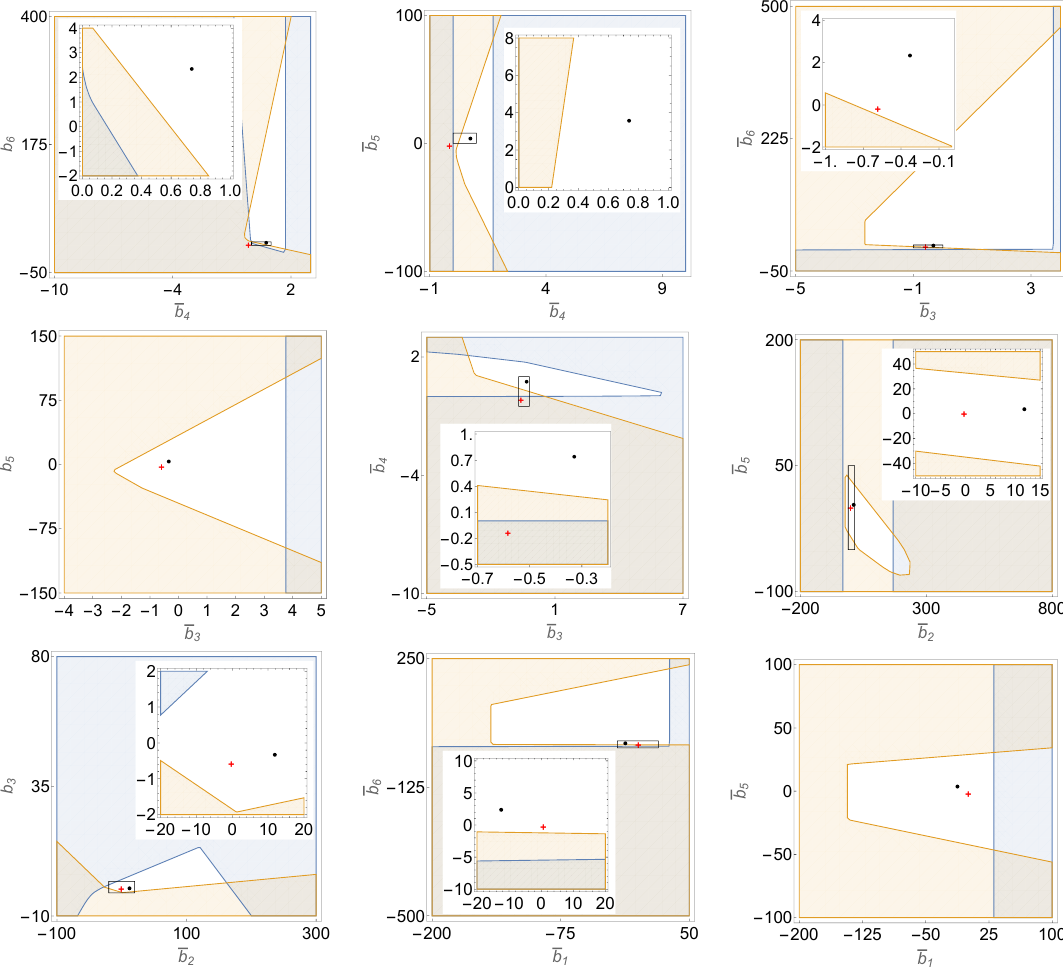
Figure 6 . 2D sections of the constrained b i space. The 2D sections are obtained by setting the other 4 parameters to the central values of the (cid:12)t (4.12). The yellow (blue) region is the region ruled out by the bounds with (cid:17) = 1 ( (cid:17) = 0). The black point represents the central values of the (cid:12)t (4.12) with inputs from the experimental data and theoretical estimates, and the red cross represents the theoretical point computed from the Weinberg Lagrangian. To be continued in (cid:12)gure